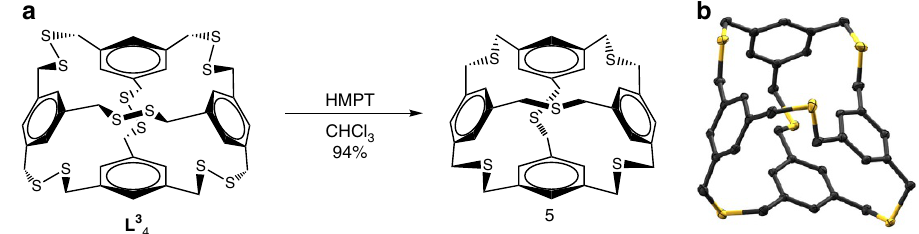
Figure 4 | Synthesis and crystal structure of a thiatetrohedrophane. Desulfurization ( a ) of L 3 4 gives tetrathioether [3 4 ]tetrahedrophane 5 (6mol HMPT). Single-crystal X-ray structure representation of thiatetrahedrophane 5 ( b ); all thermal ellipsoids at 50%. Hydrogen atoms and solvents of crystallization have been omitted for